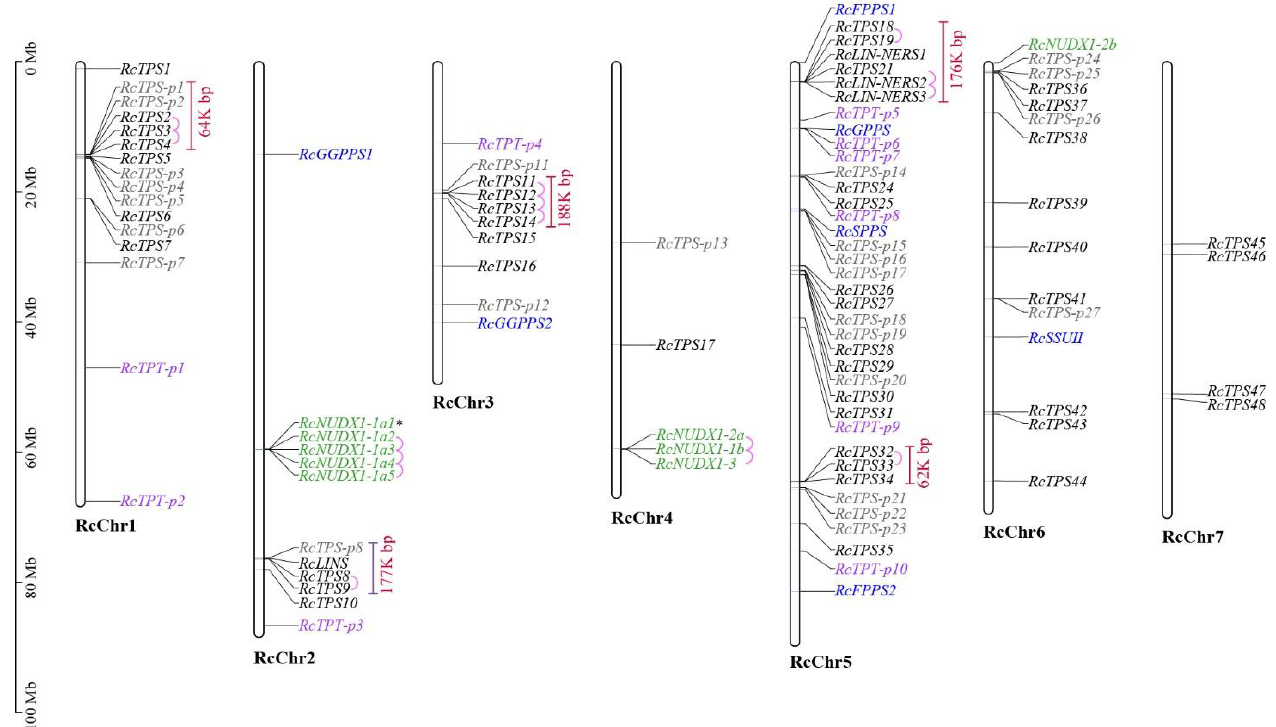
Figure 3. Chromosomal distribution of RcTPSs , RcTPTs , and RcNUDX1 genes in the R. chinensis genome. The corresponding IDs of RcNUDX1 genes are listed in Table S4. Black letters represent putative complete TPS genes, blue letters represent complete trans -prenyltransferase (TPT) genes, gray letters represent putative partial/pseudo TPS ( TPS-p ) genes, purple letters represent partial TPT (TPT-p) genes, and green letters represent RcNUDX1 genes. The tandemly duplicated genes are indicated in pink lines, and gene clusters are indicated in red lines. *Asterisk indicates a stop codon is interrupting the open reading frame of this sequence [23].